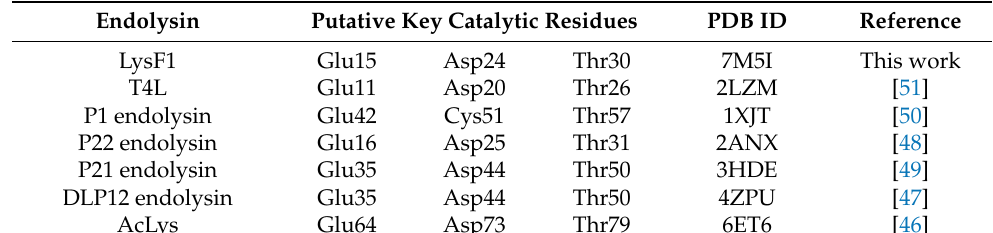
Table 3. Structurally characterized T4L-like endolysins.